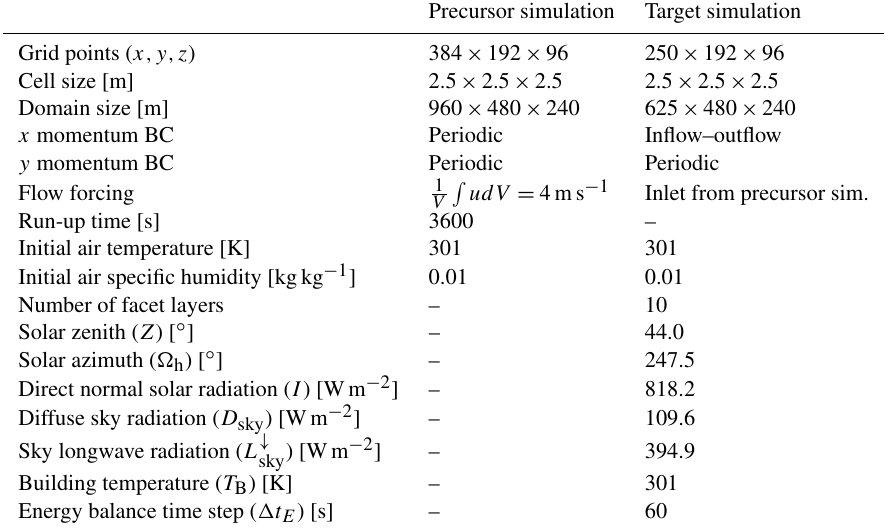
Table 4. Simulation parameters of the Eastside demo.